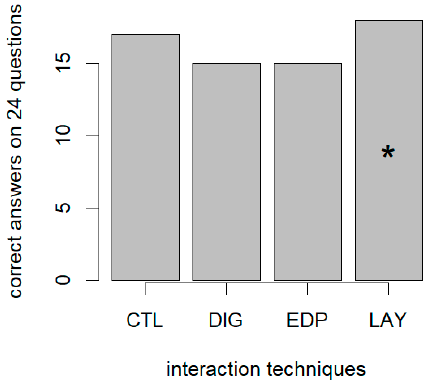
Figure 12. Number of correct distance estimations per interaction technique.